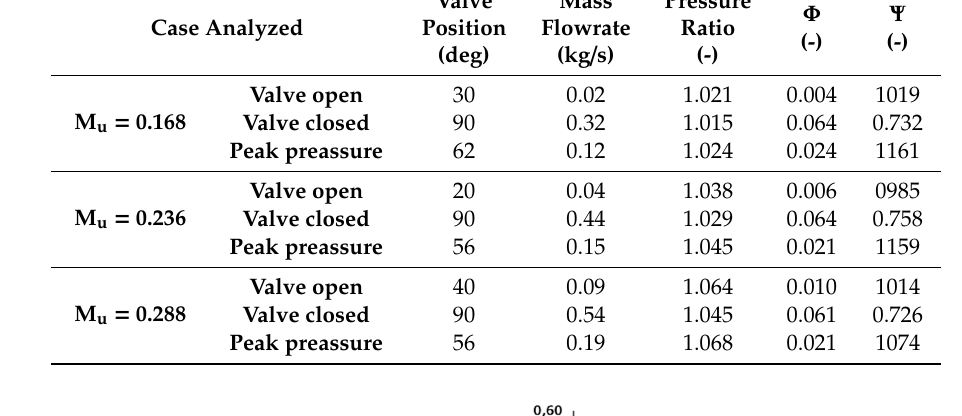
Table 2. Comparison between dimensional and dimensionless parameters of the compressor.